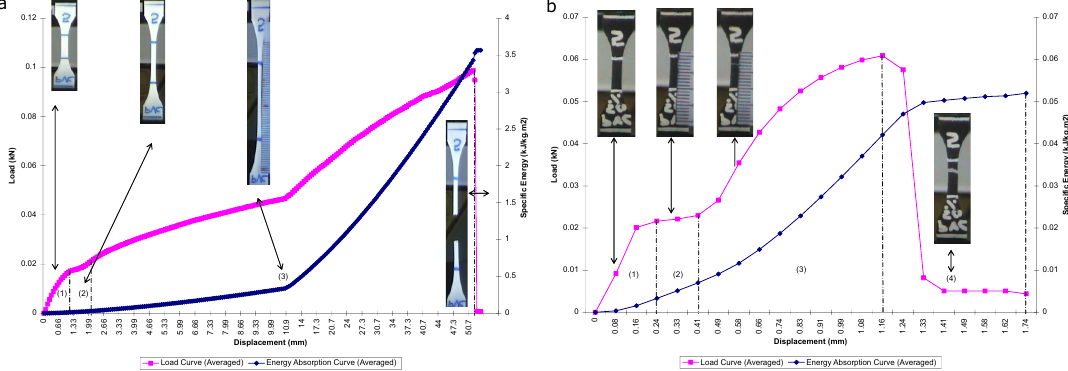
Figure 5. Load and energy absorption versus displacement: ( a ) PVC-100% and ( b ) PVC-50%/COTTON